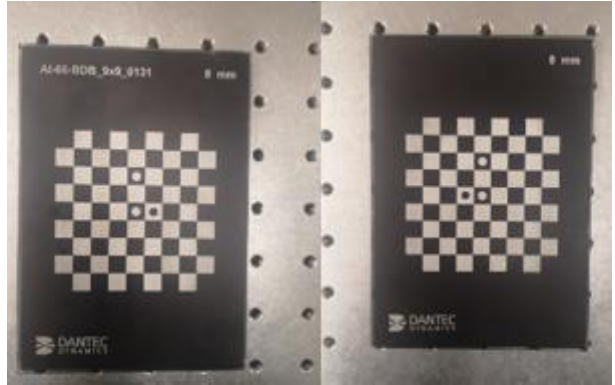
Figure 4. Double side calibration plate (front and back side).